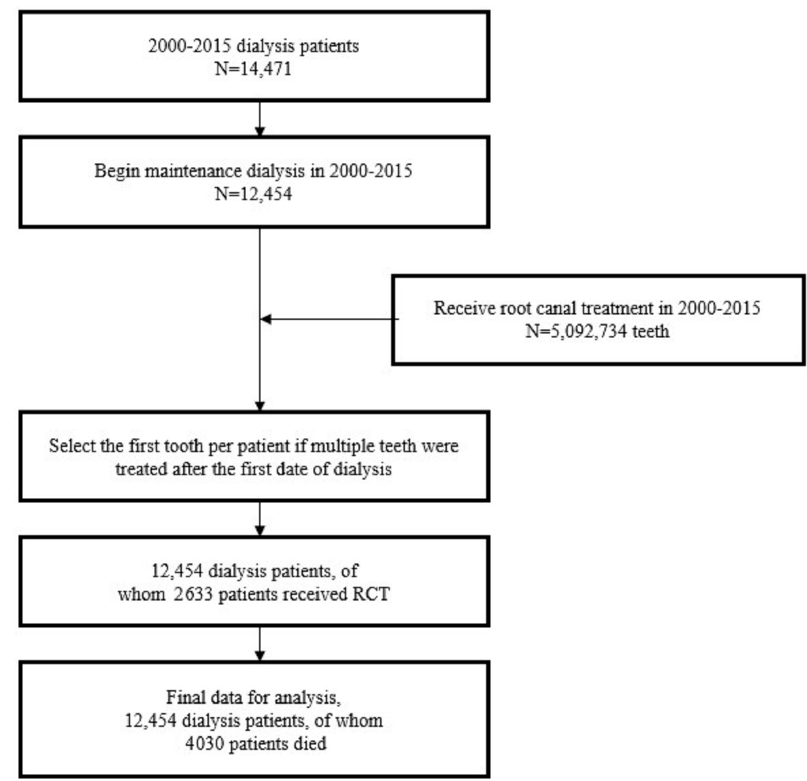
Figure 1. The retrospective cohort study flow